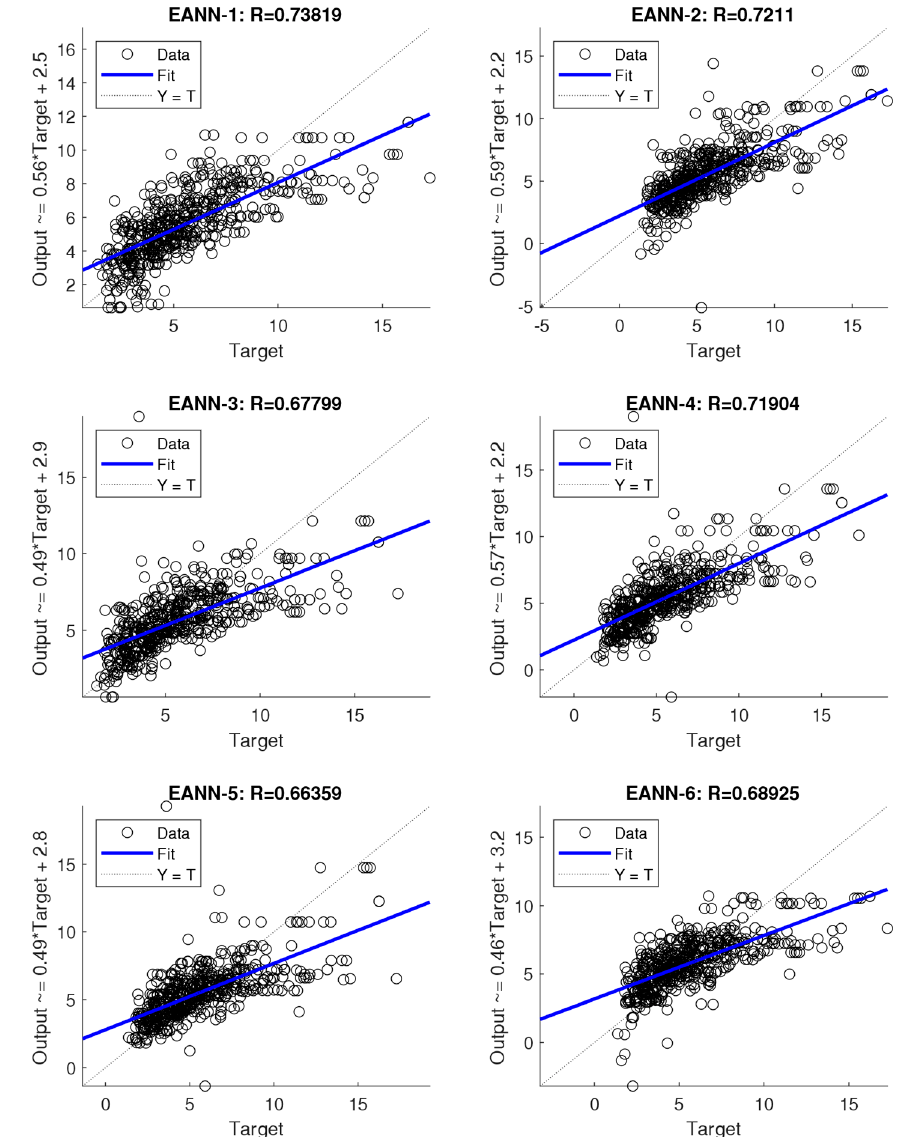
Figure 6. Predictions of the six examined ANN models for strain.